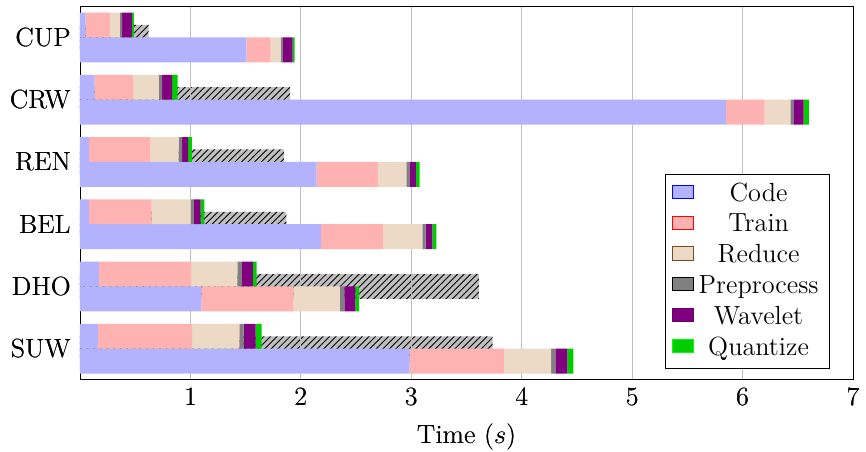
Figure 14. Speedup when using an FPGA as an accelerator. For each image, the top bars indicate the sped-up version, and the bottom bars are the non-sped-up one. A dashed bar indicates the real-time threshold, which without acceleration was only met by the DHO